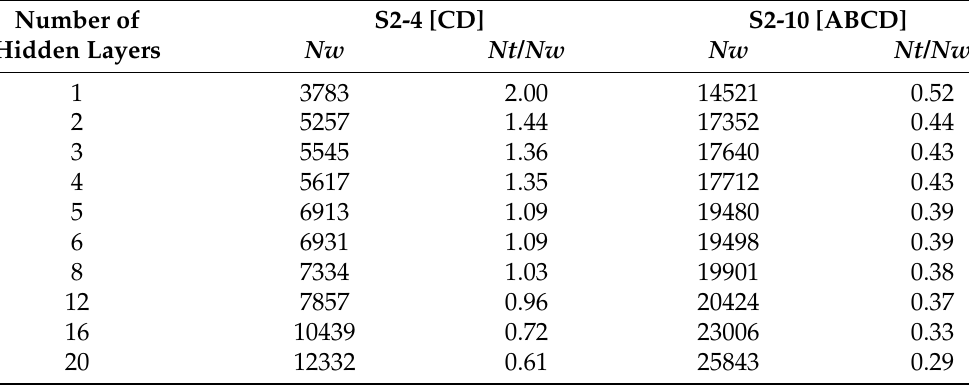
Table 6. Different depths of neural networks tested in the study. Number of hidden layers shown with the number of trainable weights for two different sets of network inputs ( S2-4-CD w3 and S2-10-ABCD w3 ) that were used in the tests. In addition, the ratio of the number of training data vectors ( Nt = training and validation sets combined) and the number of network weights ( Nw ) are shown. For the model structure coding, see Section 4. Number of S2-4 [CD] S2-10 [ABCD] Hidden Layers Nw